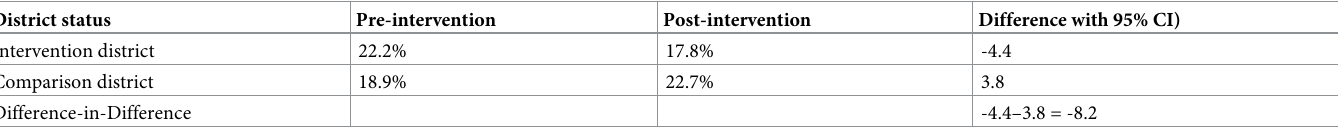
Table 2. Difference-in-Difference on prevalence of diarrhea in children less than five years in intervention and comparison districts, Jimma zone, Oromia region, Ethiopia, 2019 (N = 836). District status Pre-intervention Post-intervention Difference with 95% CI) Intervention district 22.2% -4.4 Comparison